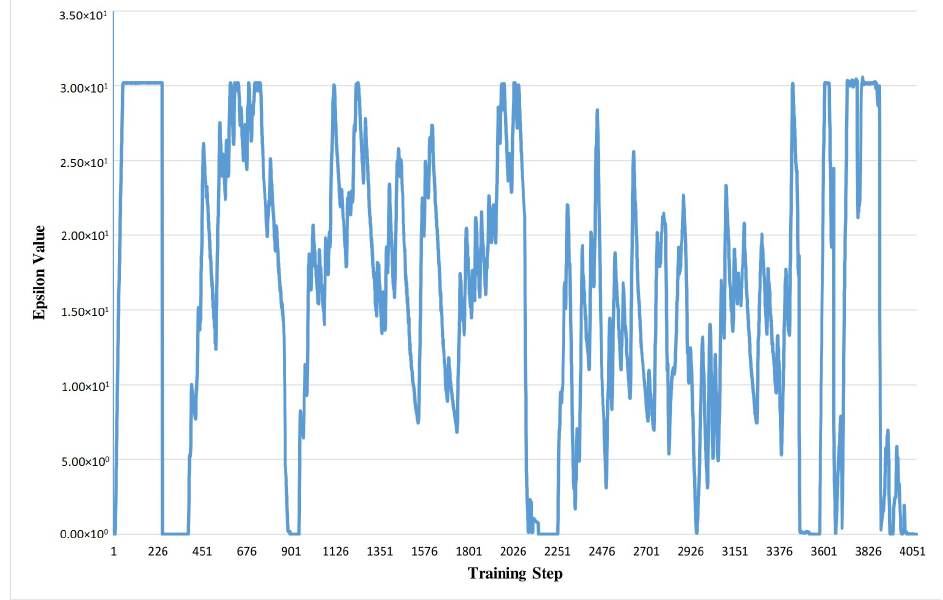
Figure 6. Training data model object classification: epsilon